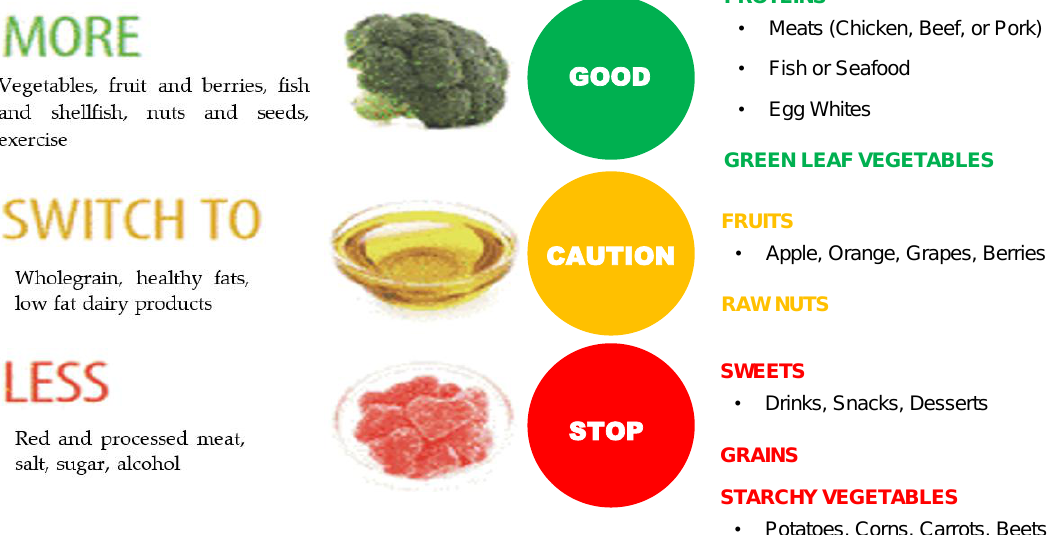
Figure 7. The Scandinavian food guide.